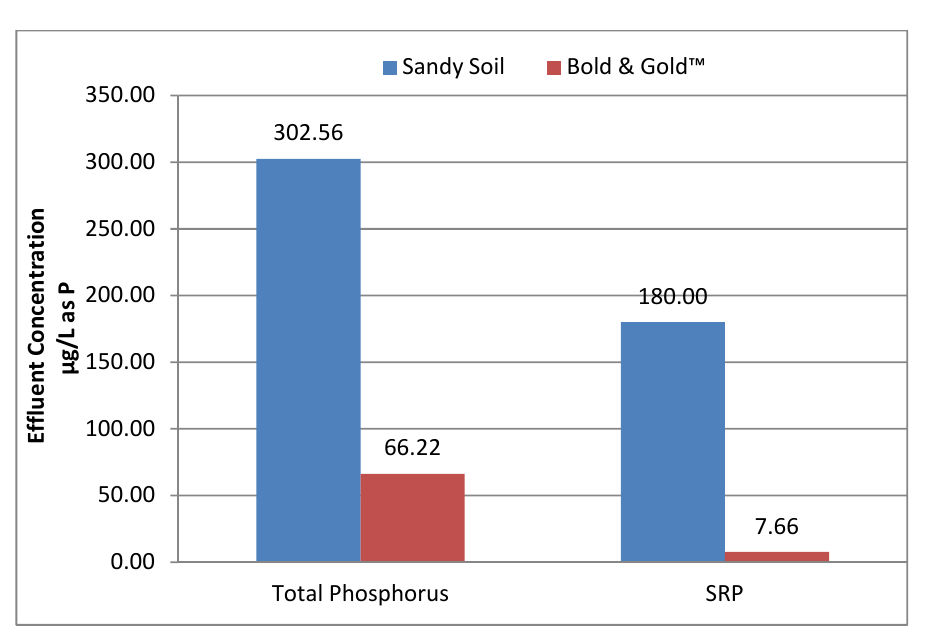
Figure 10. Average total phosphorus & soluble reactive phosphorus effluent concentrations of field scale bio-filtration systems.